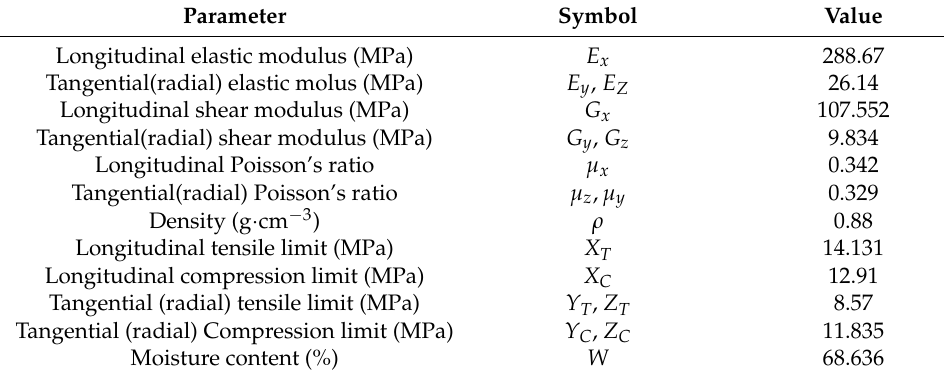
Table 1. Green pepper branch material